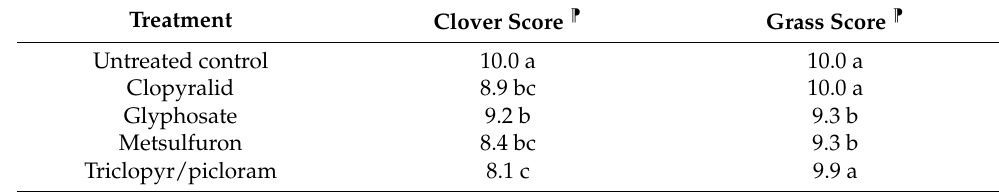
Table 4. Injury scores to pasture clovers and grasses for a double pass 5 weeks after application of herbicides, where 1 = total mortality and 10 = no effect.